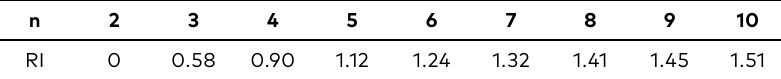
Table 4. Random Index